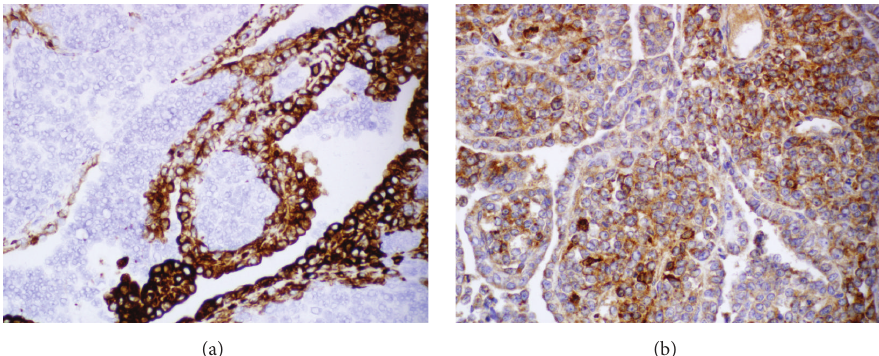
Figure 5: (a) Surface mesothelial cell component strongly reactive for calretinin, immunohistochemistry × 400. (b) Both the small cell component and the larger lining cells were reactive with antibodies against CD99, immunohistochemistry × 400.